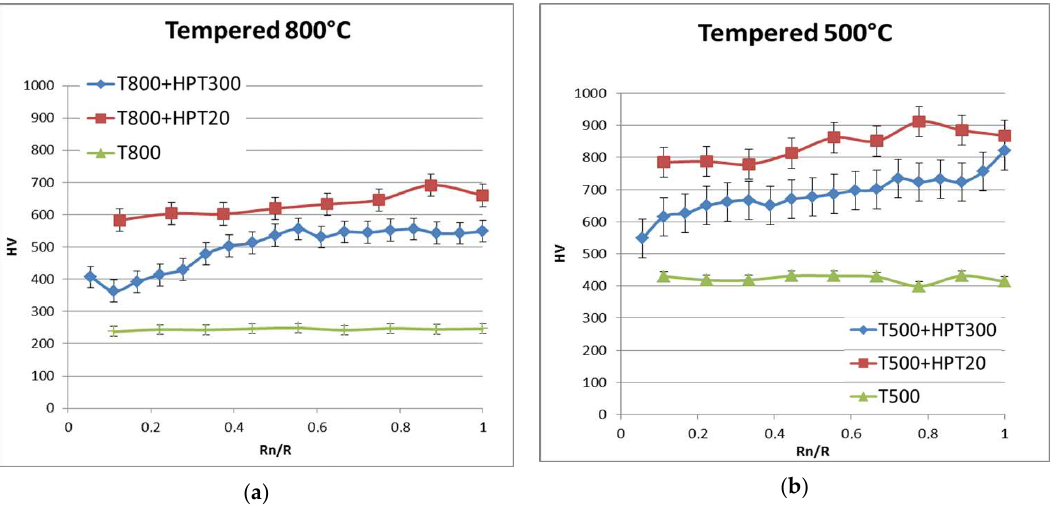
Figure 7. Vickers microhardness plotted against the distance to the center in the HPT samples: ( a ) red—T800 + HPT20, blue—T800 + HPT300, green—tempered sample; ( b ) red—T500 + HPT20, blue—T500 + HPT300, green—tempered sample. Rn/R—distance from center of the disc.